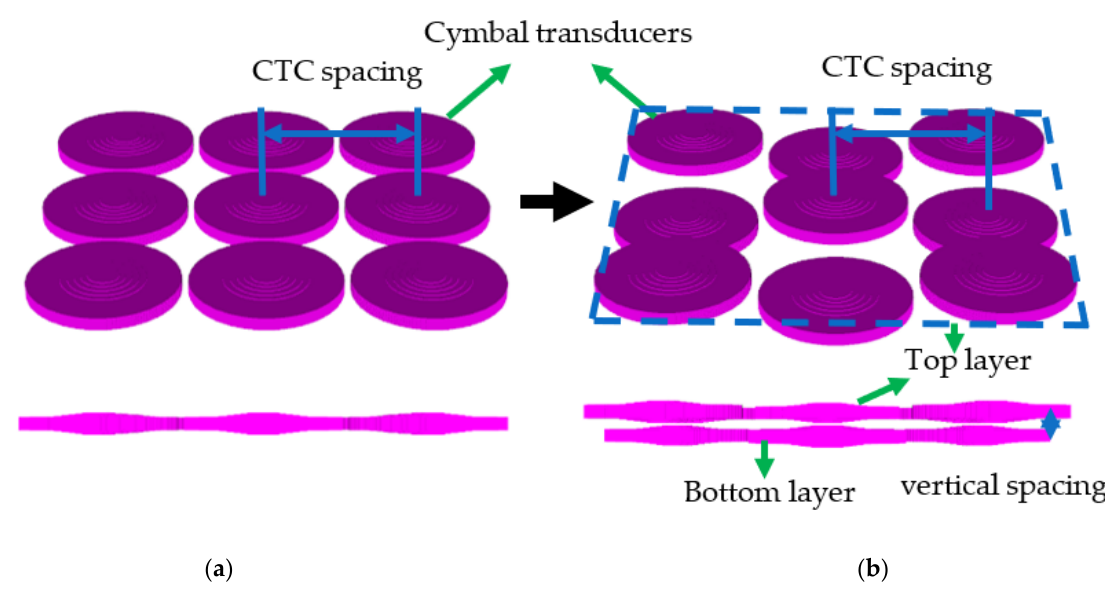
Figure 2. Arrangement of the 3 × 3 cymbal arrays in: ( a ) one layer; ( b ) two layers.